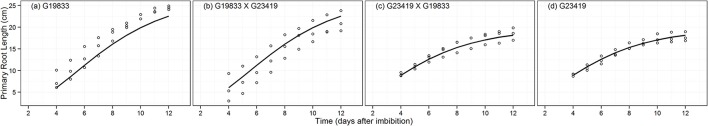
Fitted Gompertz growth function for primary root length (PRL, cm) data of parental genotype (A) G19833, the reciprocal F1 hybrids (B) (G19833 × G23419) and (C) (G23419 × G19833), and parental genotype (D) G23419.